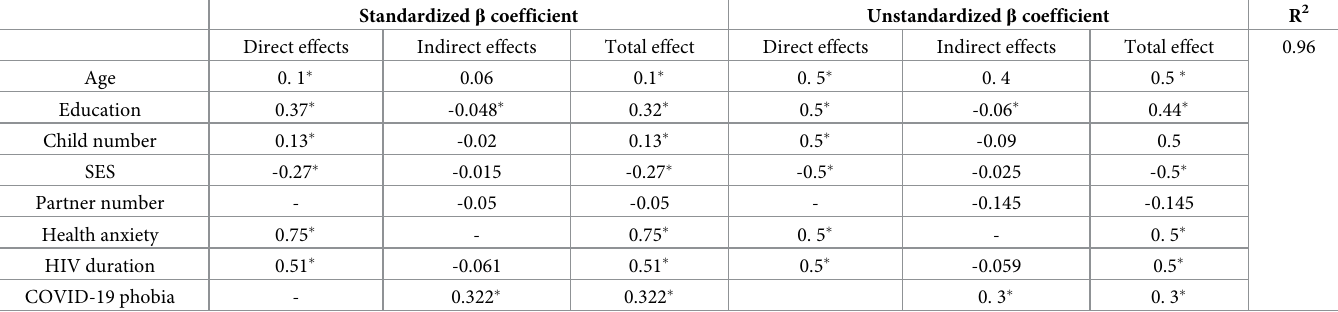
Table 3. The direct and indirect effects of sociodemographic variables, health anxiety, COVID-19 phobia and social relations in PLWH.